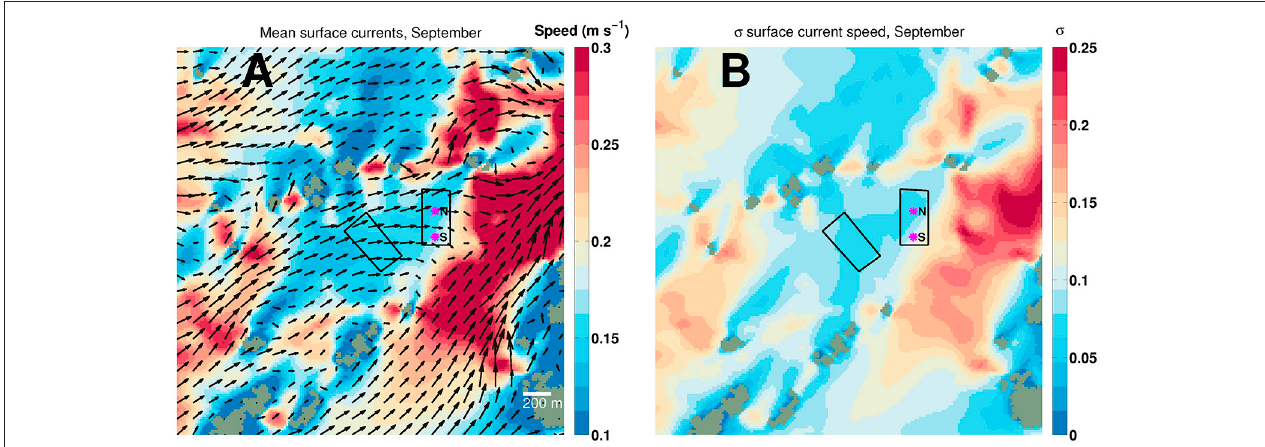
FIGURE 5 | Simulated mean surface currents at location 2 for September 2011. (A) The colors indicate mean current speeds, while the black arrows indicate the direction. (B) Temporal standard deviation. The black rectangles in both panels indicate the position of the fish farm cage arrays. The short side of the cage arrays is 200m long, also indicated by the white segment in (A) . Note that these panels display only a minor part of the complete domain for the hydrodynamic model ( Figure 2 ).